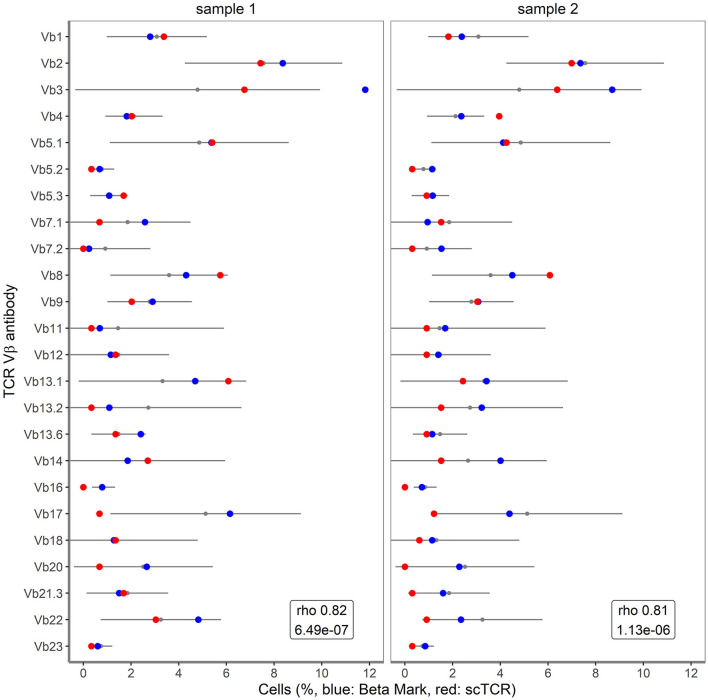
Correlation of single cell TRB clonotypes with BetaMark flow-based single cell TCRVβ test. Shown are the percentages of 24 TCRVβ families for sample 1 and sample 2 as obtained using BetaMark kit (depicted in blue) together with the TCRVβ reference values as determined using 10 healthy donors (depicted with black line) vs. single cell TRB clonotypes (depicted in red).